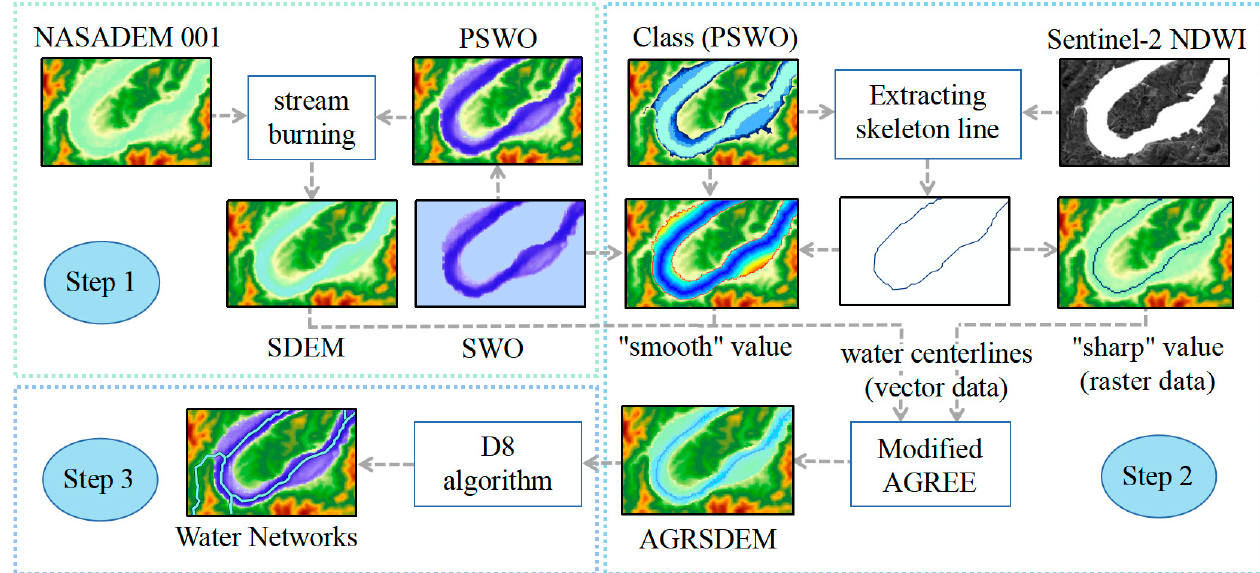
Figure 1. AGRSDEM framework combined stream burning, modified AGREE, and D8 algorithm to extract the river network. extract the river